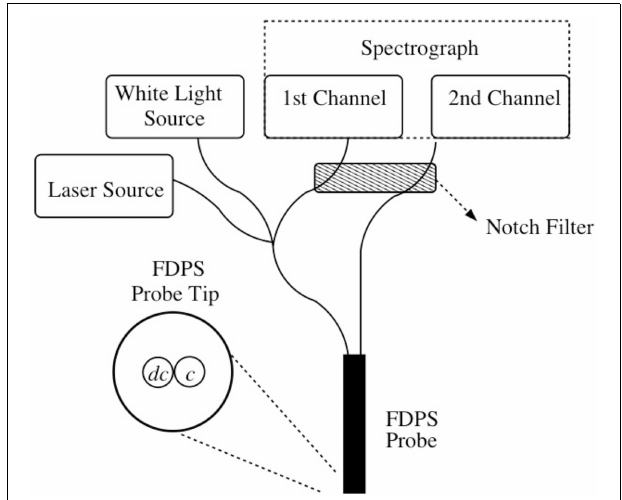
FIGURE 1 | Setup of the FDPS system. The dc (delivery/collection) fiber in the probe excites the tissue with white light and laser light sequentially while both the dc and c (collection) fibers collect and transfer light to the